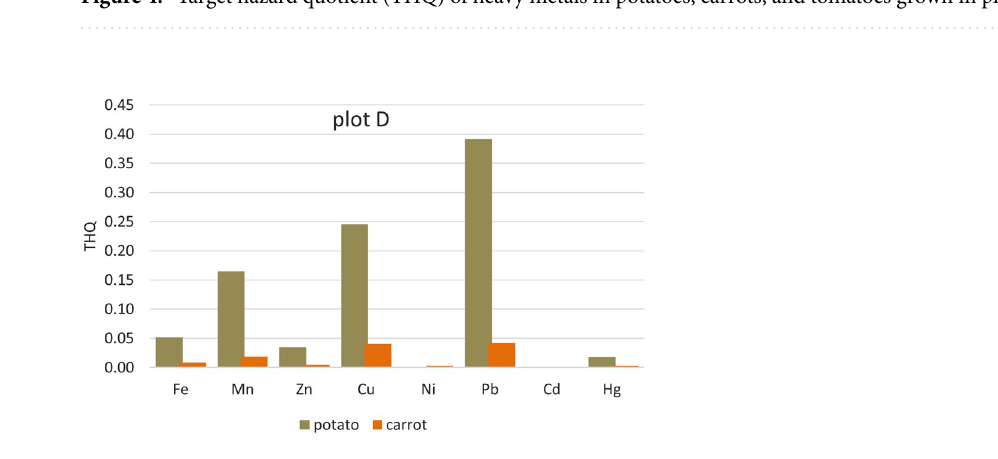
Figure 5. Target hazard quotient (THQ) of heavy metals in potatoes, carrots, and tomatoes grown in plot